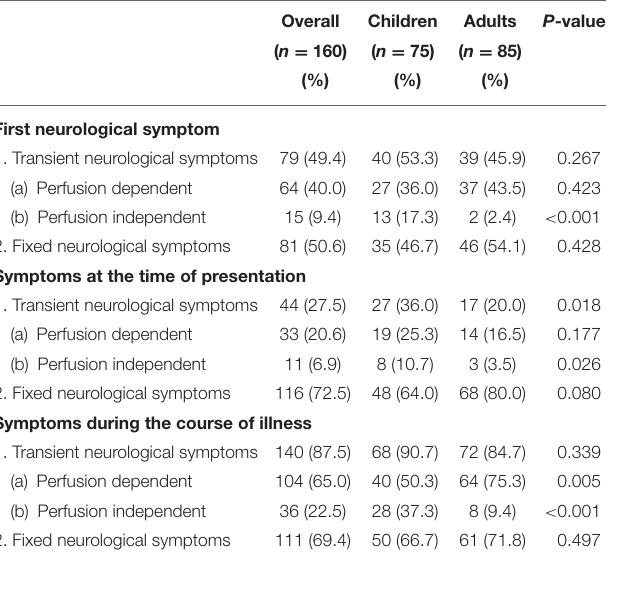
TABLE 3 | Frequency of transient and fixed neurological symptoms at different instances of disease course.